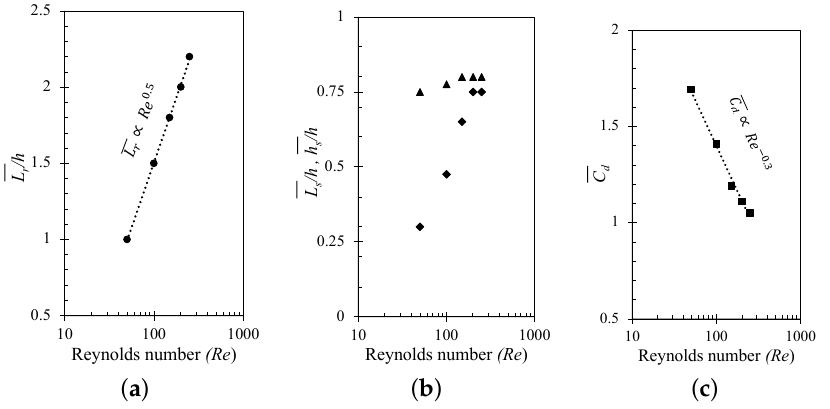
Figure 25. The variation of ( a ) wake size ( L r as • ), ( b ) height of the mean wake structure ( h s as (cid:78) ), and its distance from the rear face ( L s as (cid:7) ), and ( c ) mean drag coefficient ( C d as (cid:4) ) at a range of Re .